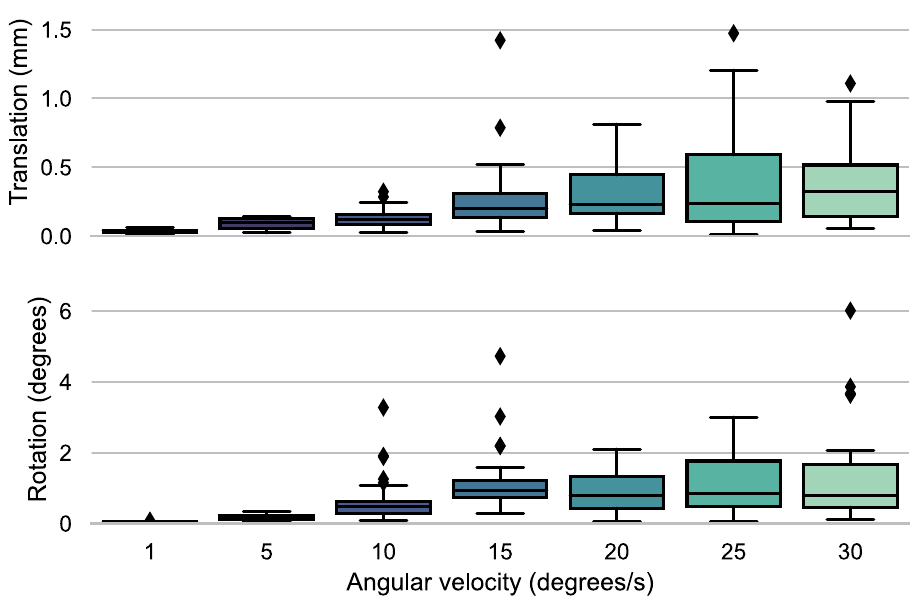
Figure 6. Motion artefact induced error: The error in registration when the scanned subject is rotating at different angular velocities. The translational error in mm is shown in the upper subgraph, while the roational error in degrees is given by the lower subgraph. Imaging technique: